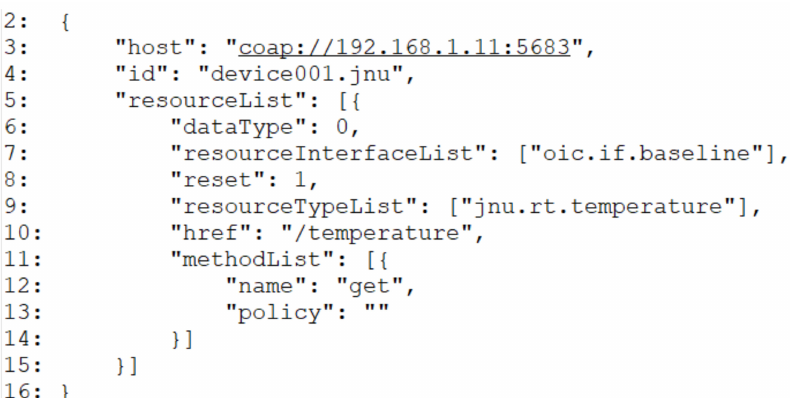
Figure 5. Registration profile